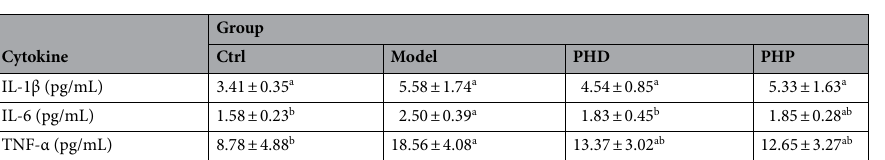
Table 4. Effect of PHD and PHP on the immune cytokines of rats. Data are expressed as mean ± SD (n = 5). Different lowercase letters (a, b and c) were significantly different at the level of p < 0.05.